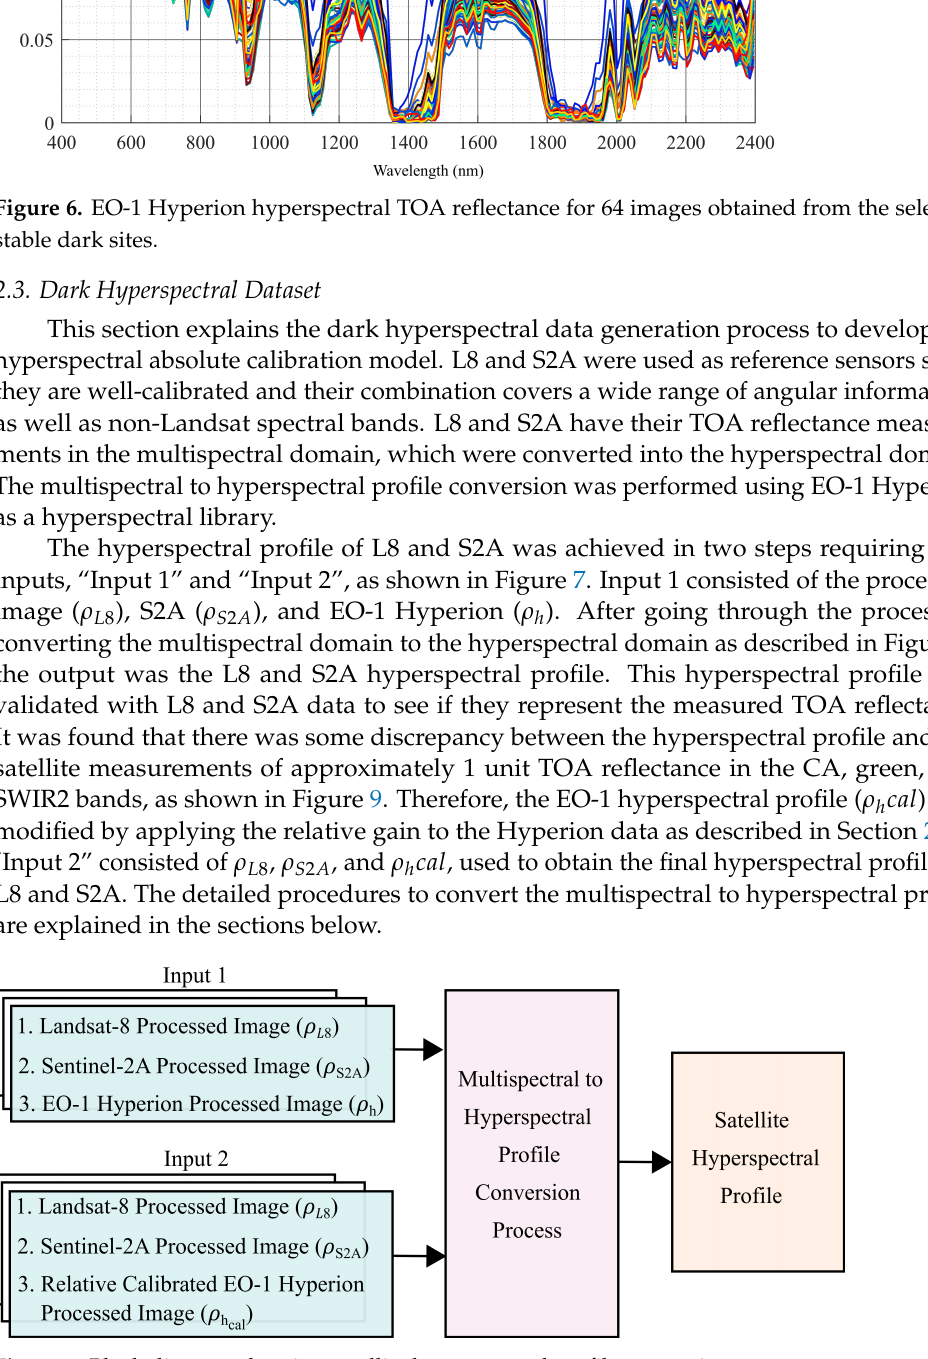
Figure 7. Block diagram showing satellite hyperspectral profile generation